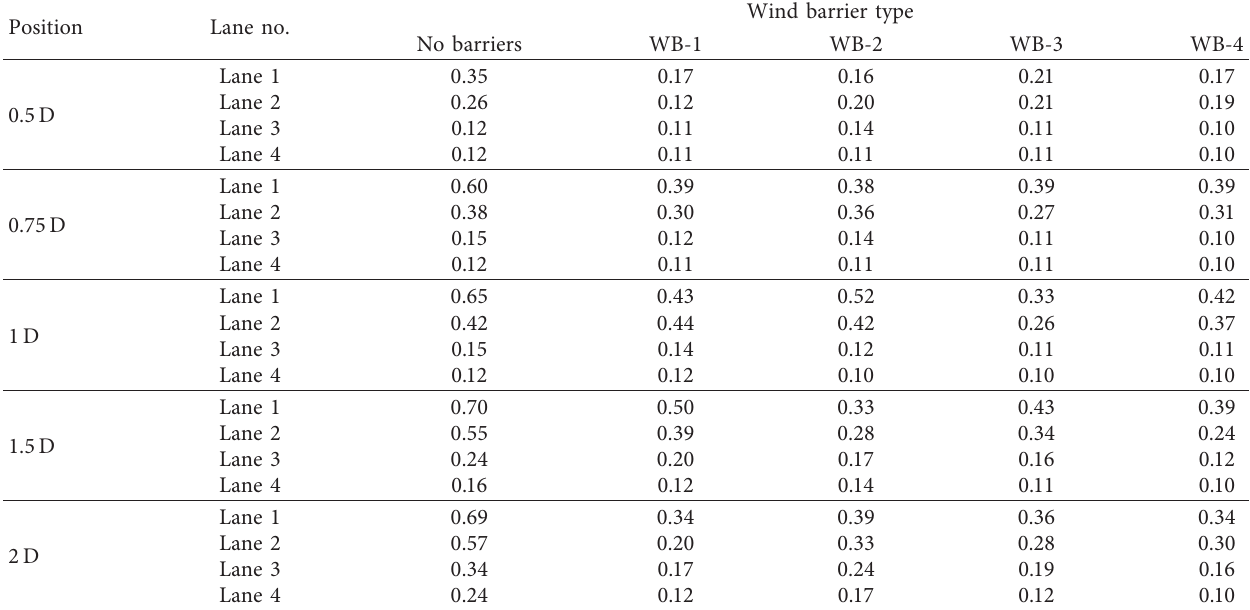
Table 2: Normalized wind speed under different conditions. Position Lane